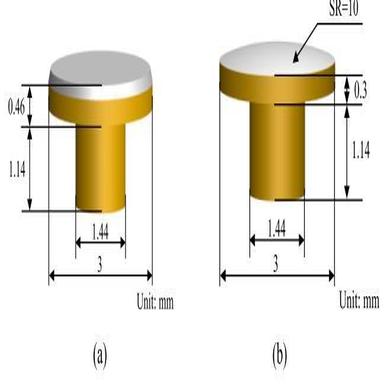
The geometry of specimens. (a) Stationary electrode. (b) Movable electrode.